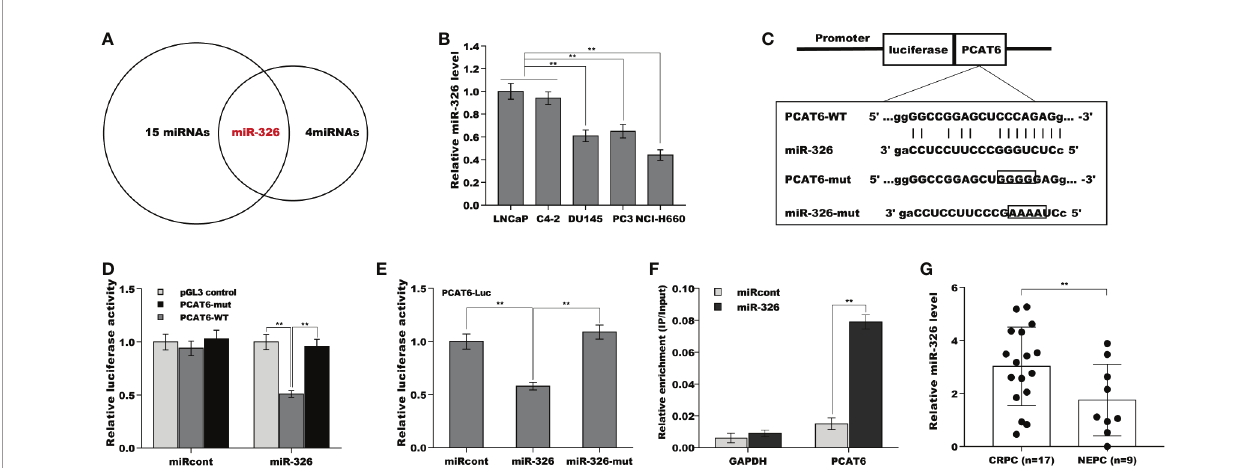
FIGURE 4 | PCAT6 functioned as a ceRNA and sponged miR-326. (A) Starbase v2.0 database was used to predict potential miRNA binding sites in PCAT6. (B) qPCR analysis of miR-326 mRNA expression in NE-like cells (PC3, DU145, and NCI-H660) and LNCaP and C4-2 cells. (C) Schematic representation of the miR- 326 site in PCAT6-3 ’ UTR. (D) Luciferase activity was assayed in LNCaP cells co-transfected with miR-326 and luciferase reporters containing PCAT6-WT or PCAT6- Mut. Data are presented as the relative ratio of fi re fl y luciferase activity to renilla luciferase activity. (E) Luciferase activity was assayed in LNCaP cells co-transfected with luciferase reporters containing PCAT6-WT and miR-326 or miR-326-Mut. (F) The direct binding of PCAT6 to miR-326 was af fi rmed using luciferase reporters in LNCaP cells treated with miR-326 or miR-326-mut. (G) qPCR analysis of miR-326 level in CRPC tissues (n=17) and NEPC tissues (n=9). ** p